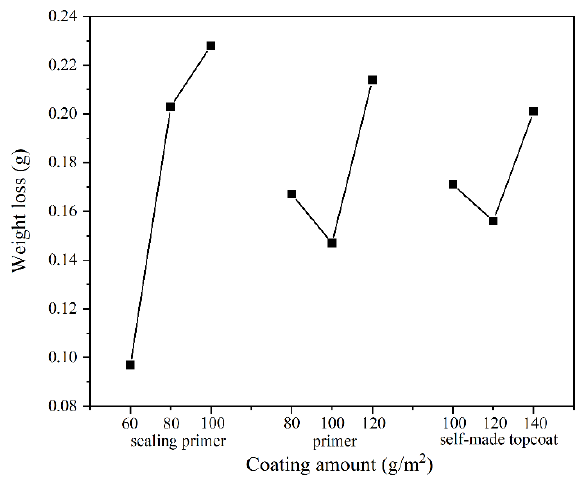
Figure 8. Relationship between coating amount and weight